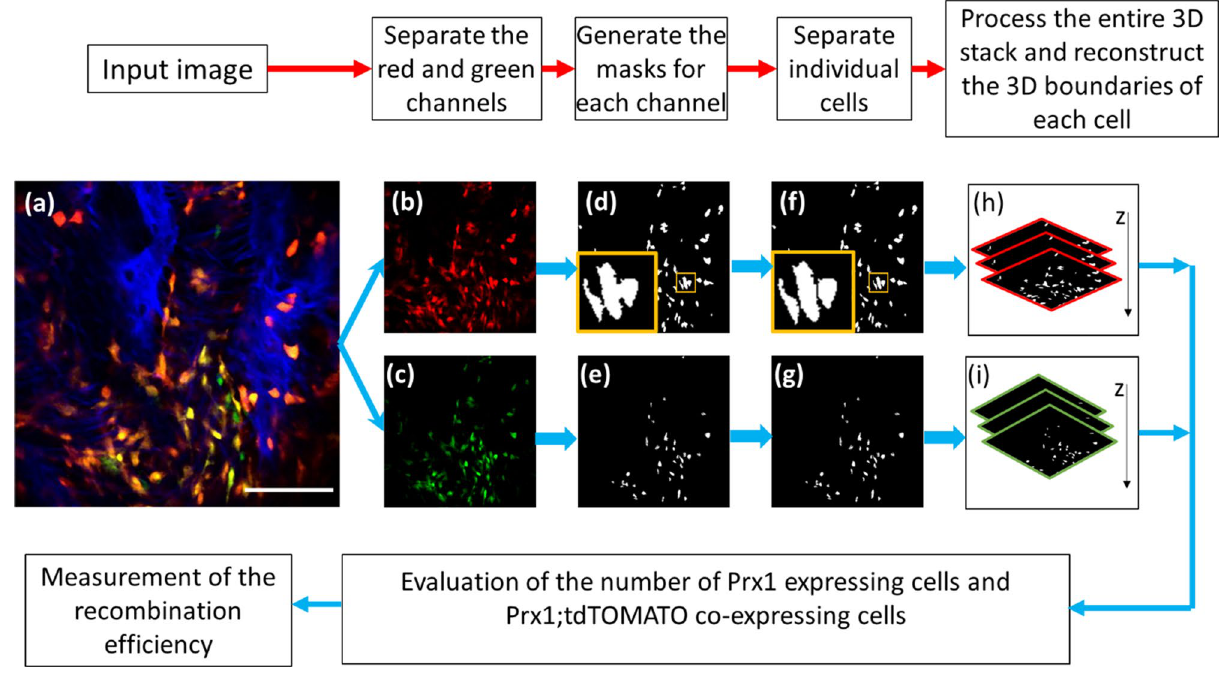
Figure 1. Image processing and automatic cell counting workflow. ( a ) A representative input image uploaded into Matlab program. After acquisition, the input image is processed to separate the red channel ( b ) and the green channel ( c ), which represent the cells that express tdTomato and Prx1 (eGFP) respectively. Subsequently, a three-component Otsu thresholding is independently applied to each channel, to generate a mask for tdTomato expressing cells ( d ) and Prx1 (eGFP) expressing cells ( e ). A marker-controlled watershed algorithm is applied to further separate the connected tdTomato expressing cells ( f ) and Prx1 (eGFP) expressing cells ( g ) into individual cells. The orange insets in ( d ) and ( f ) show connected cells (in d ) that are successfully separated (in f ). Then, 3D reconstructed masks for the tdTomato expressing cells ( h ) and for the Prx1 (eGFP) expressing cells ( i ) are generated to calculate the final recombination